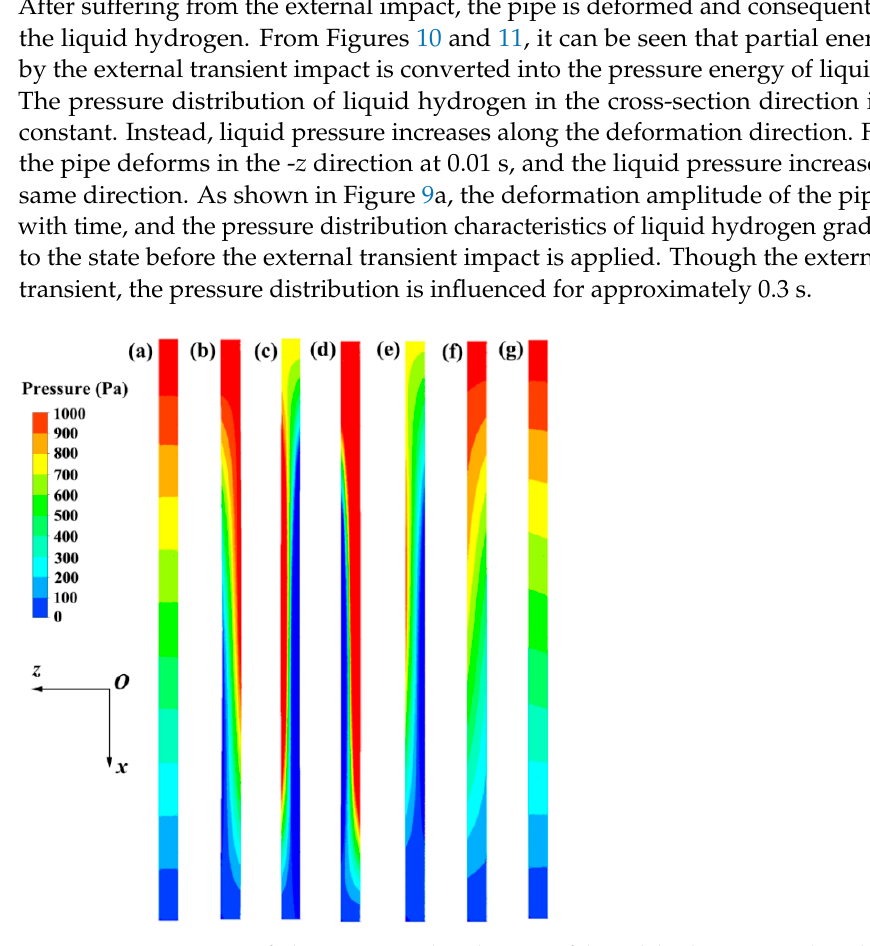
Figure 9. Vertical deformation of the impact point in z direction: ( a ) with liquid hydrogen in the pipe; ( b ) without fluid in the pipe.